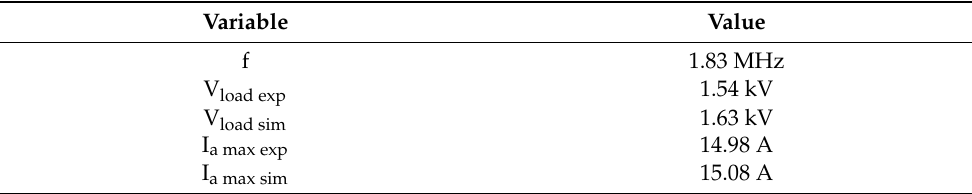
Table 4. Measurement and simulation results.